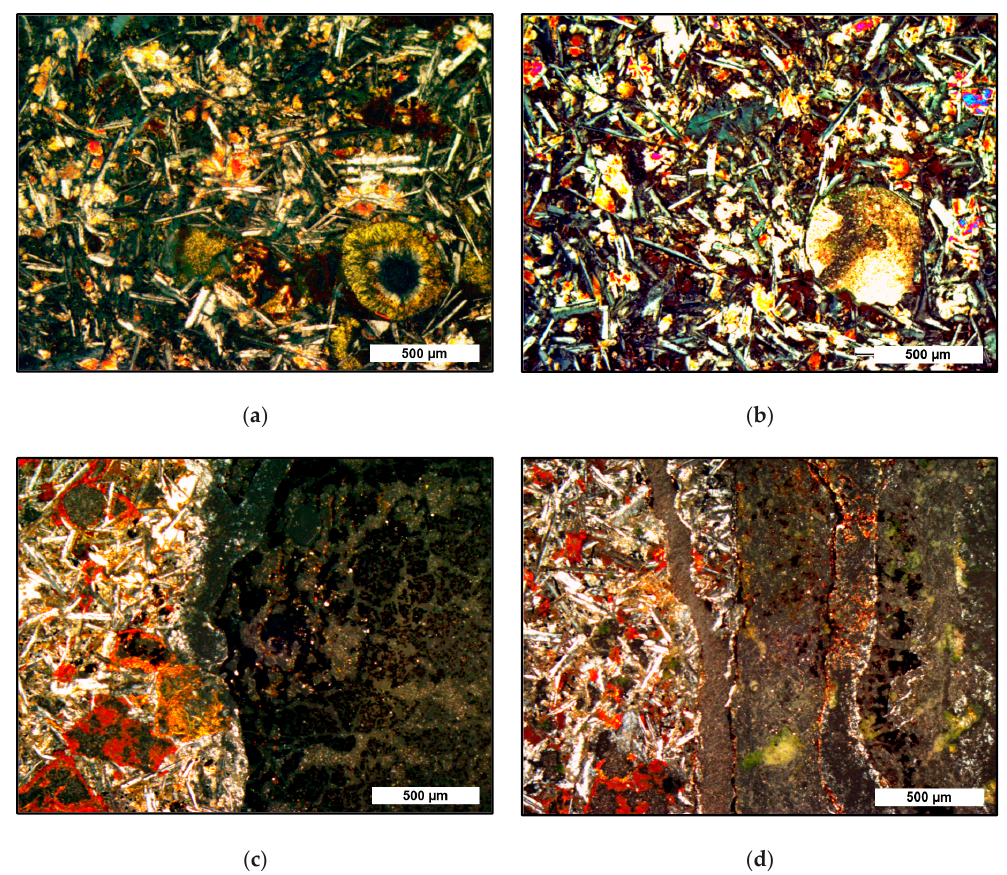
Figure 3. Representative transmitted light photos of the DR-9 sample; basalt interior ( a ), ( b ) and basalt-crust alteration zone ( c ), ( d ): ( a ) several plagioclase twinnings, small pyroxenes and vesicule filled with fibrous-like green celadonite; black non-opaque minerals were identified in EPMA as Fe-Cr rich spinels and pseudobrookite; ( b ) porphirous, intergranular, needle-like texture with visible plagioclases, pyroxenes, non-opaque minerals and vesicule filled with chalcedony; ( c ) plagioclase twinnings with altered pyroxenes (red zones) and dispersed non-opaque minerals; starting from centre to right—the colomorphs complex composed of Fe-Mn oxyhydroxides and greyish Fe-rich clay minerals; ( d ) several plagioclase twinnings with altered pyroxenes and small veinlets filled-up with the mixture of clay minerals (Fe-smectite, nontronite), green authigenic hydroxyapatite and glauconite; visible on the right—black colomorphs and patches of Fe-Mn oxyhydroxides.